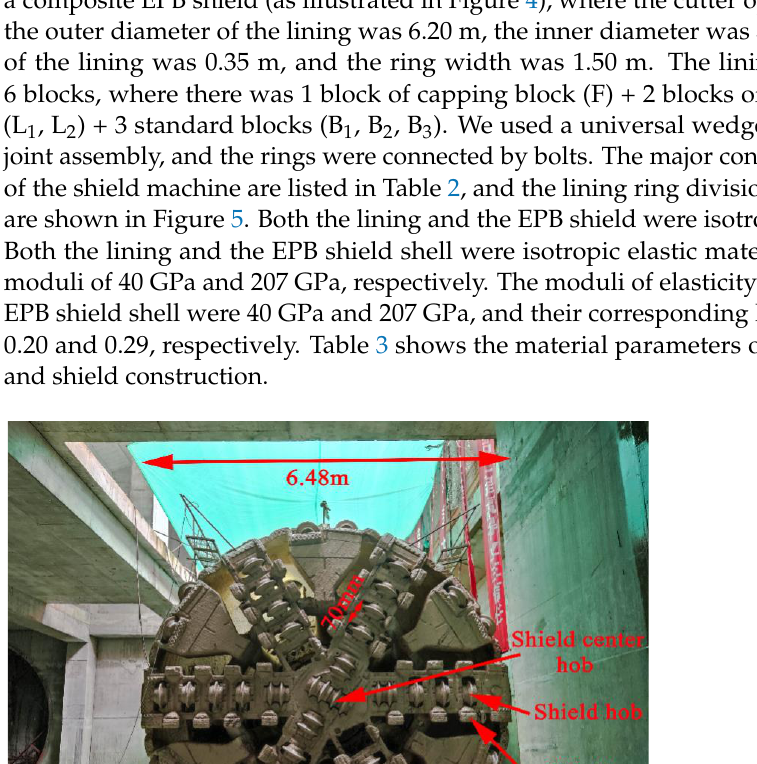
Figure 3. Schematic diagram of finite element model: ( a ) three-dimensional numerical model; ( b ) spatial location model of old and new tunnels.